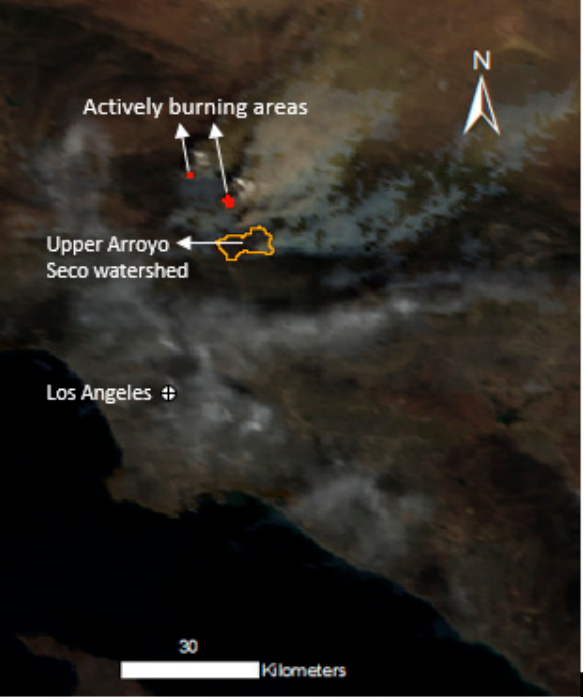
Figure 3. Composite natural-color satellite image obtained from MODIS Surface Reflectance bands 1 (red), 4 (green) and 3 (blue) on 30 August 2009, during ‘Station Fire’. Figure 4 was obtained from the public domain site: https://www.usgs.gov/media/im-